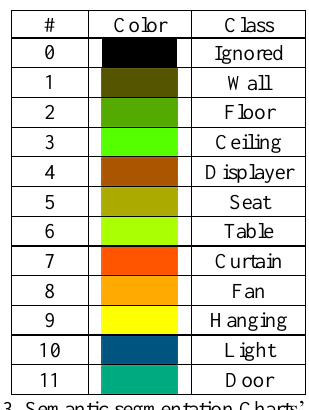
Table 3. Semantic segmentation Charts’ legend